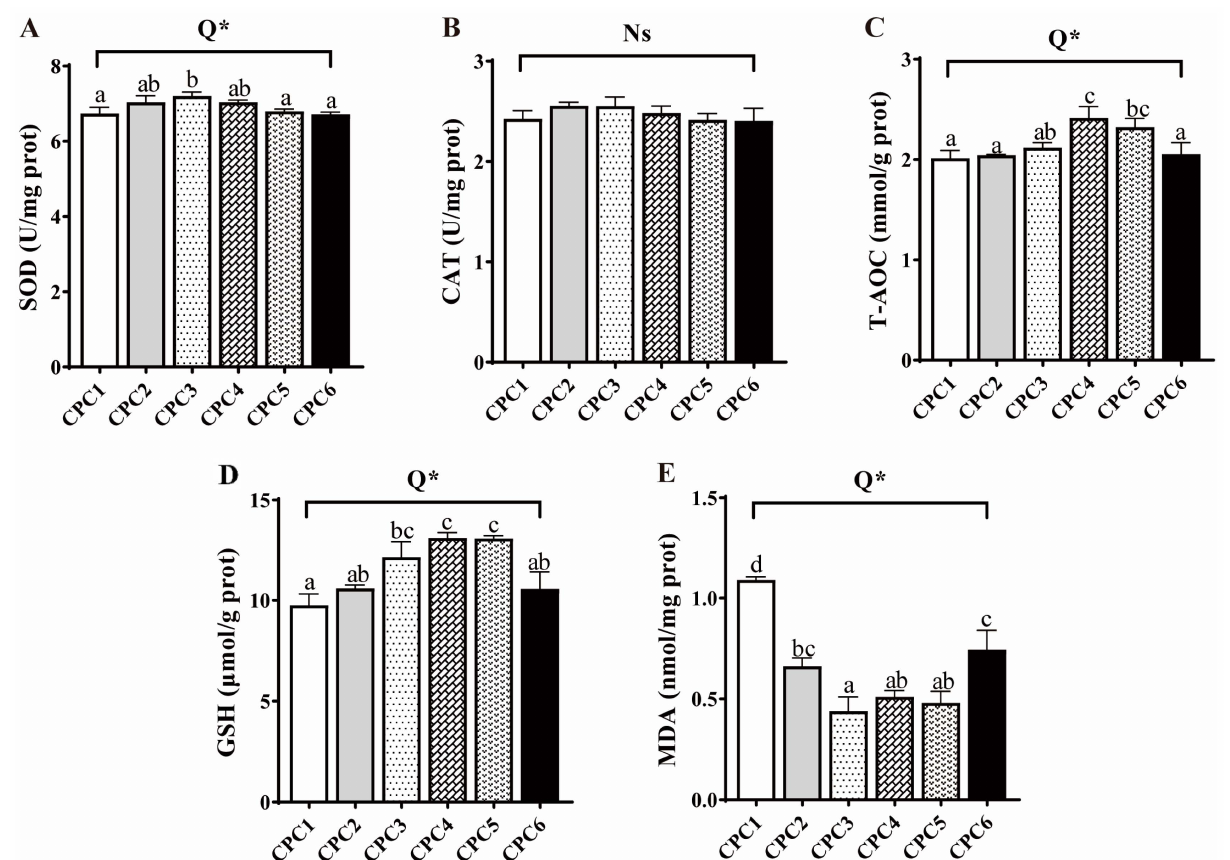
Figure 4. Effects of the dietary protein level on the antioxidant capacity of grass carp